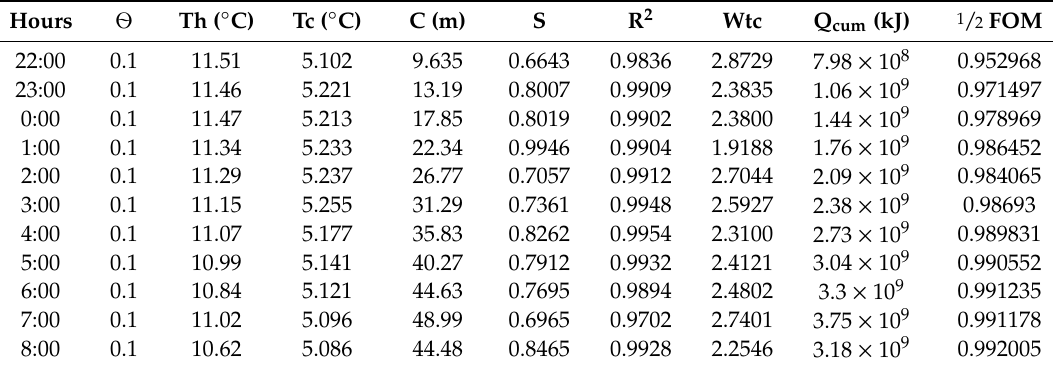
Table A5. 5th–6th January 2019 Curve Fitting and Performance Parameter analysis.